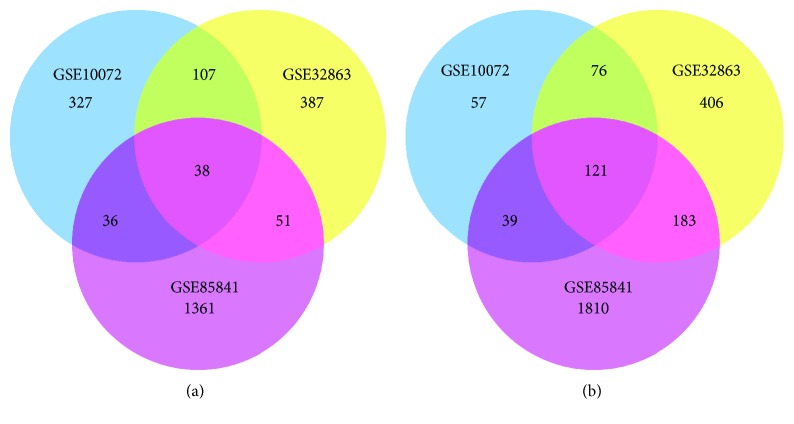
DEGs between tumor and adjacent tissues in GSE10072, GSE32863, and GSE85841. (a) Venn diagram of 38 overlapping upregulated genes. (b) Venn diagram of 121 overlapping downregulated genes.